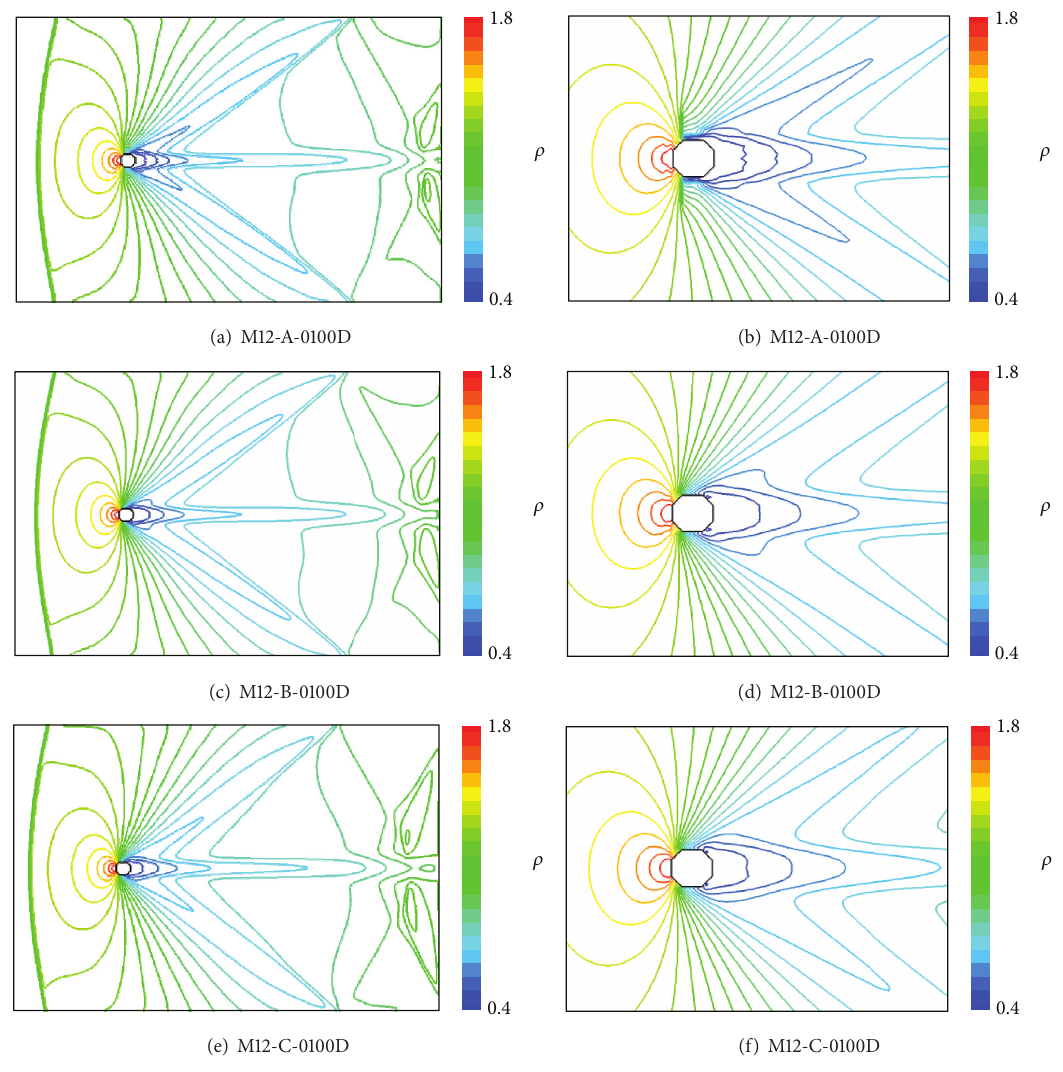
Figure 12: Density contours in Mach